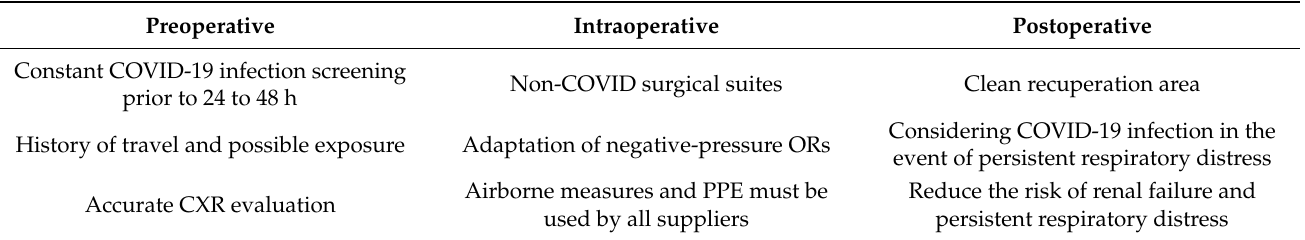
Table 2. Measures to be taken into consideration when performing a surgical